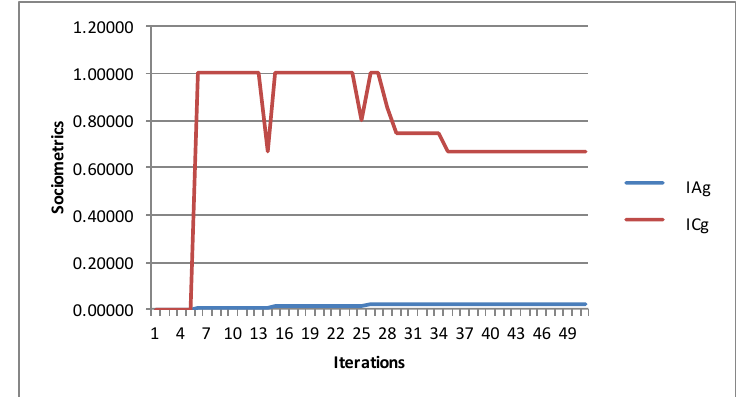
Figure 10. Temporal evolution of IAg and ICg sociometrics in a simulation execution for the scenario of Roberts [5].